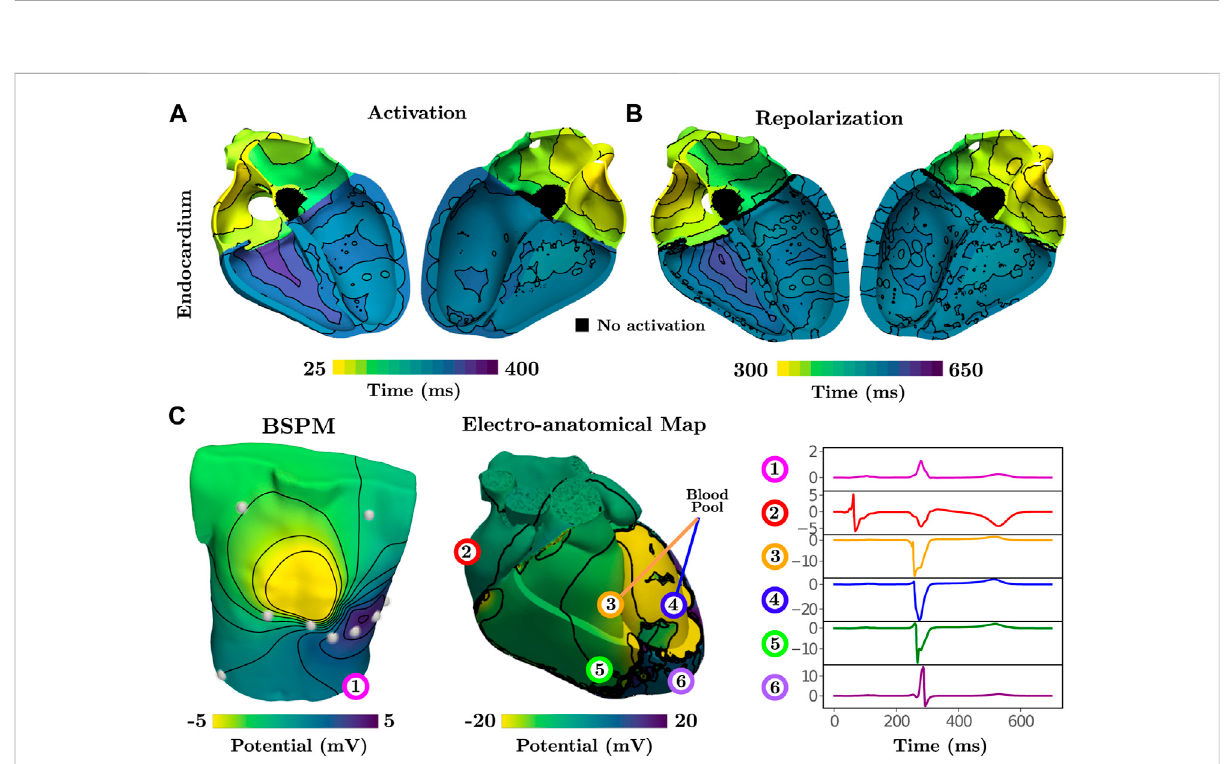
FIGURE 2 Activation and repolarization patterns during normal sinus rhythm underlying simulated ECGi information of BSPMs and EGMs. (A) Activation initiates from fascicular root sites and spreads into the fast-conducting Purkinje network. Latest activation is seen on the posterior RV free wall. (B) Repolarization is linearly dependent on activation, thus exhibiting a similar pattern. (C) The BSPM and EAM are visualized at a time point of 275 ms. Electrical potentials at 6 recording locations on the torso, on the epicardium, and in the blood pool next to the endocardium are shown for the single heart